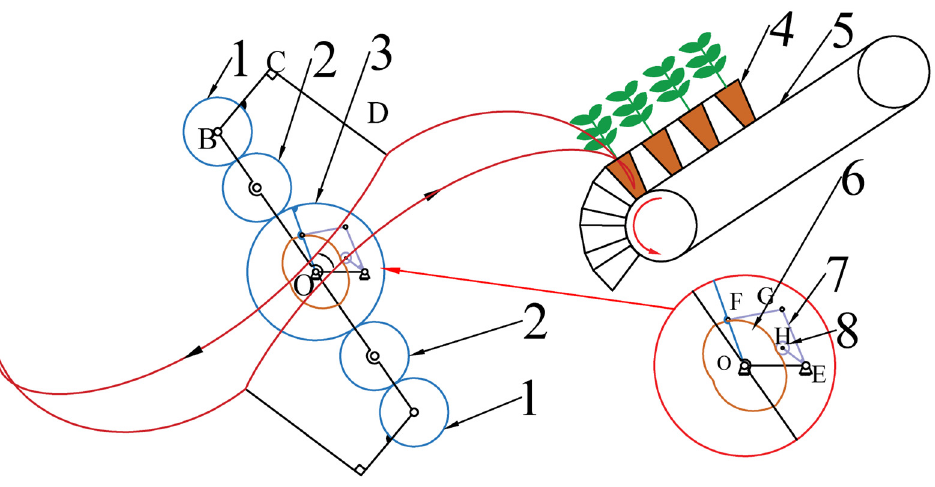
Figure 1. Sketch of seedling picking mechanism: 1. Planetary gear; 2. Intermediate gear; 3. Sun gear; 4. Seedling tray; 5. Seedling tray delivery mechanism; 6. Cam; 7. Linkage mechanism; and 8. Roller.